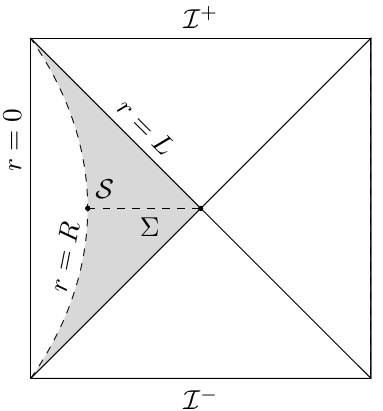
Figure 1 . A York boundary (dashed curve) at radius r = R in the dS static patch. The boundary splits the static patch into two systems: the “pole patch”, i.e., the white region between the pole and the boundary, and the “horizon patch”, i.e., the shaded region from the boundary to the horizon (the terminology comes from